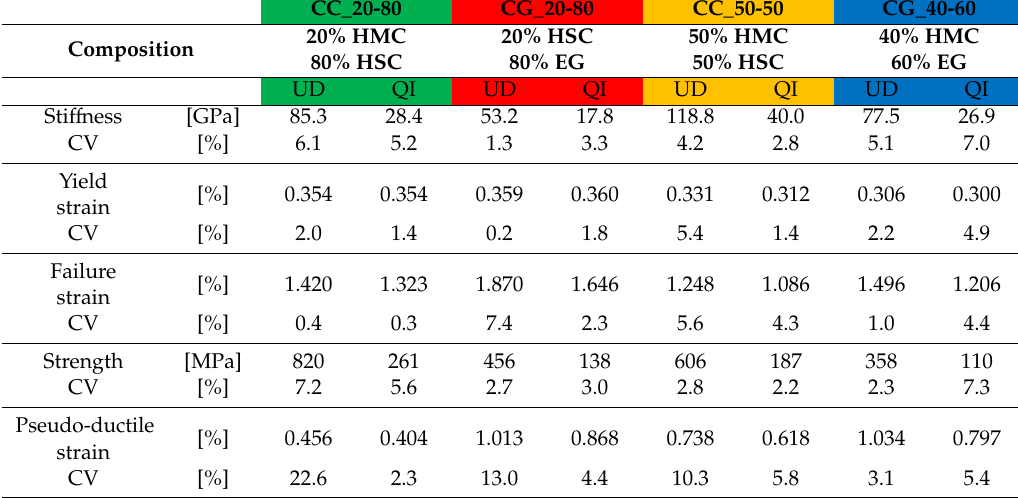
Table 3. Pseudo-ductile ADFRCs tensile test